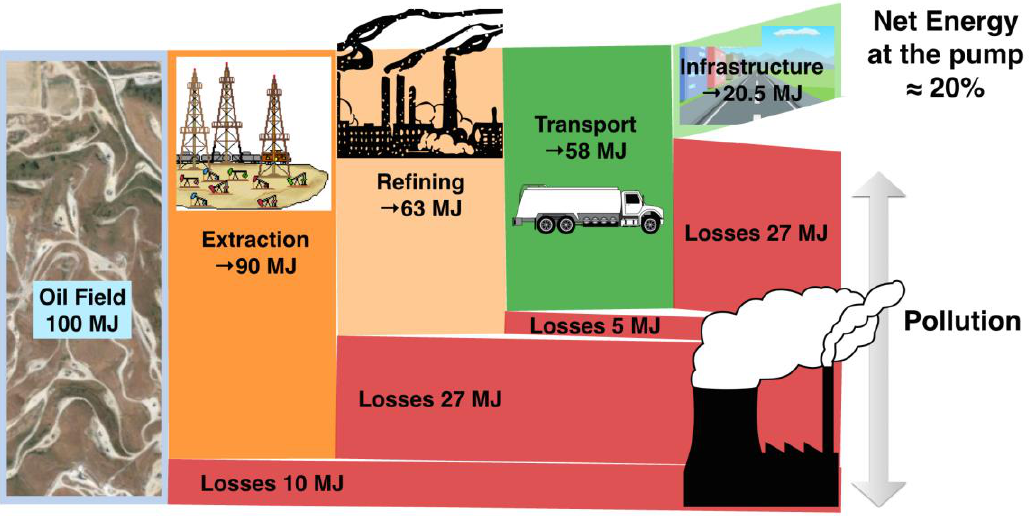
Figure 10. The sequence of losses in each step of petroleum processing is revealing [28].